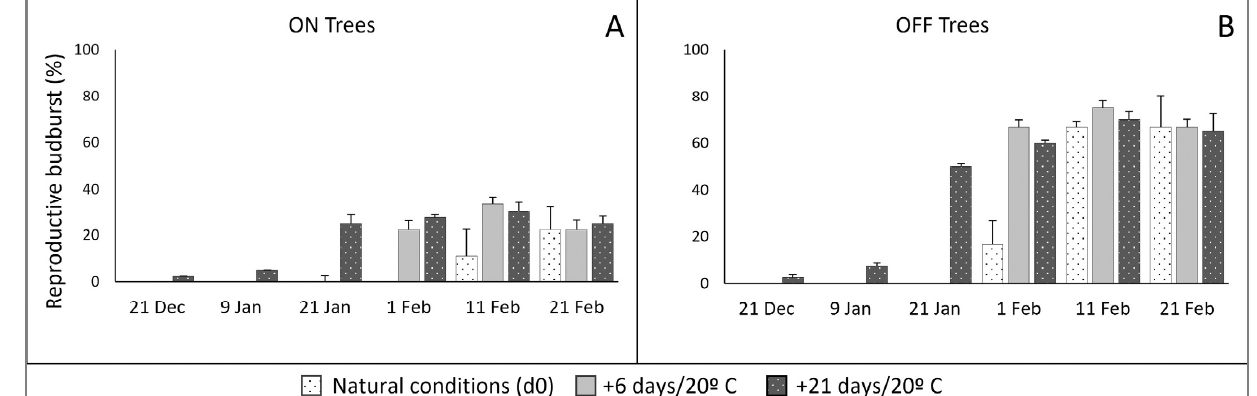
same maximum values for all three observation procedures: at the time of sampling (d0), and after forcing of cuttings at 20 °C for 6 days and 21 days.